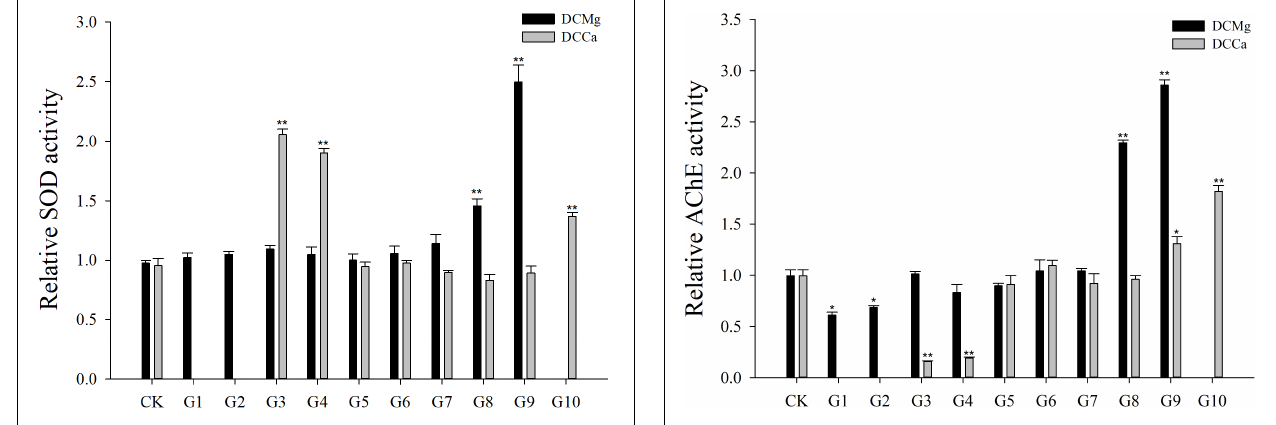
FIGURE 7 | Relative AChE activity of JSCs under long-term stress with different Ca 2 + and Mg 2 + concentrations. Results show AChE activity at 30-days normalized to the 0-day. Bars (mean ± SE, n = 3) with an asterisk denote a significant difference ( ∗ P < 0.05, ∗∗ P < 0.001) between the test groups (G1–G10) and CK.